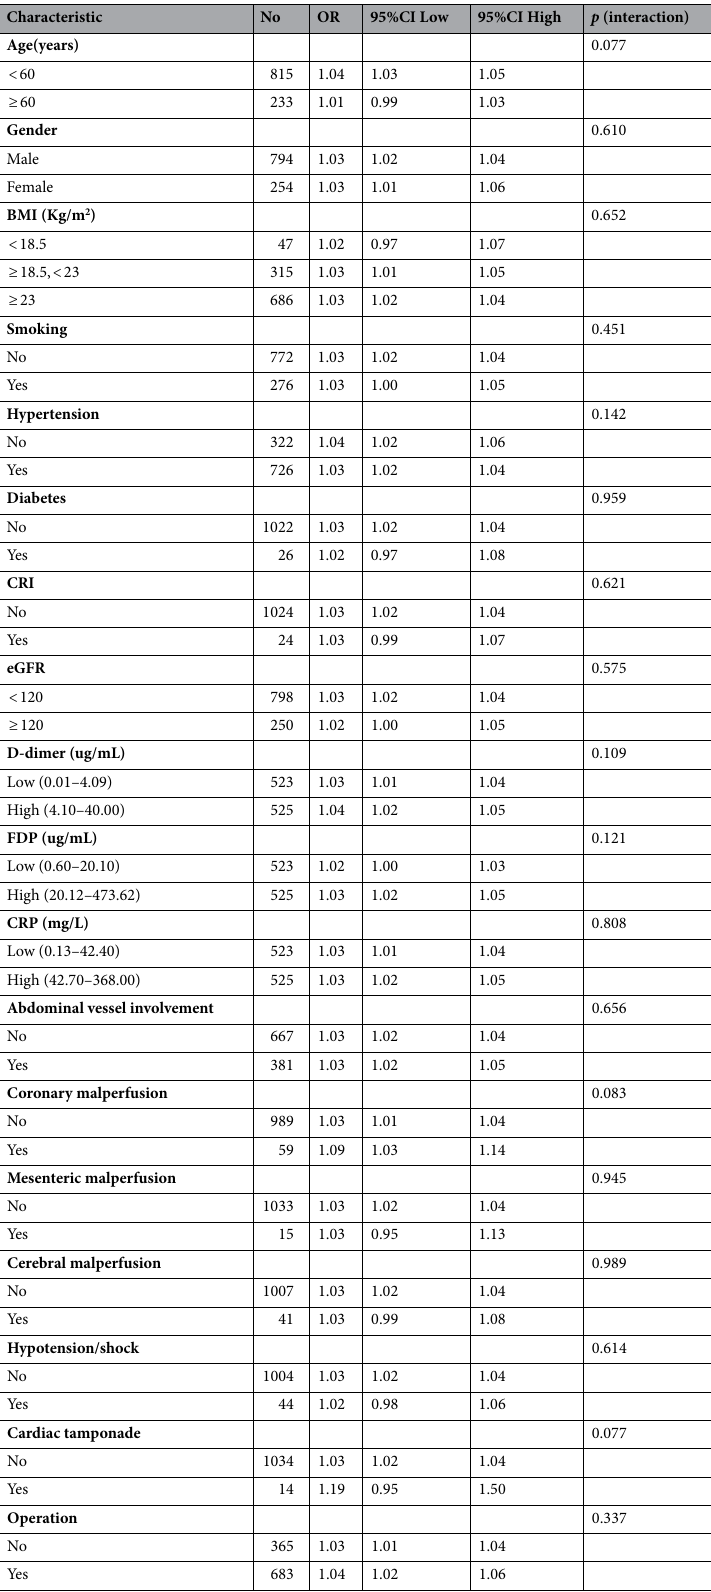
Table 5. Results of subgroup analysis and interaction analysis (UA per 10 increments). BMI body mass index, CRI chronic renal insufficiency, eGFR estimated glomerular filtration rate, FDP fibrinogen and fibrin degradation products, CRP C-reactive